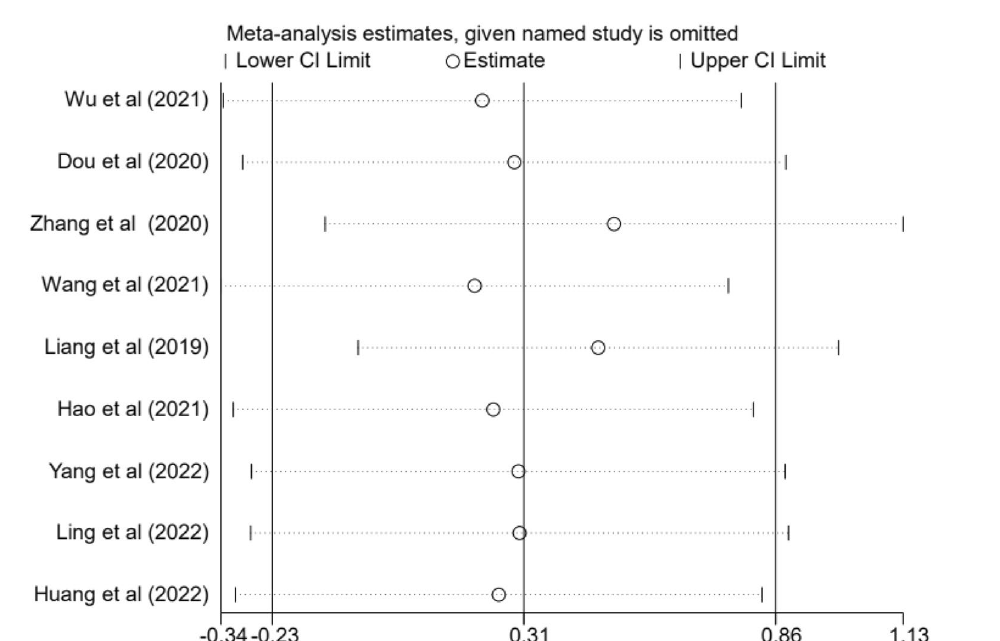
Figure 3. Sensitivity analysis for the involved